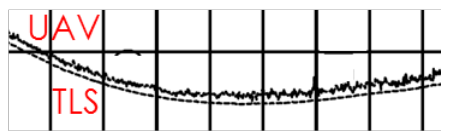
Figure 8. Sample of UAV point cloud noise and vertical separation from TLS. profile graph of Figure